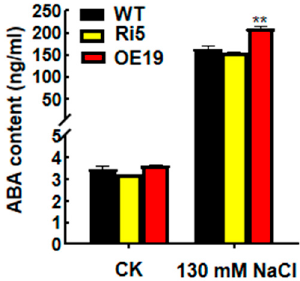
Figure 9. ABA contents in wild-type (WT) and OsASR6 transgenic plants following treatment with 130 mM NaCl and control treatment, respectively. Three independent experiments were carried out with similar results. Asterisks indicate significant differences between means of WT and transgenic lines. Data represent means ± SD. ** p < 0.01.